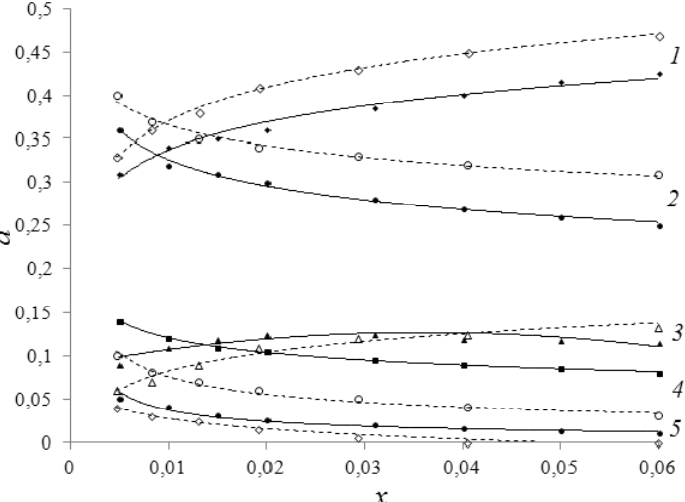
a dim( ) a dim( ) (1) and ferromagnetic f (2) Fe III ( ) Fe III ( ) a ( ) a ( ) (3) and ferromagnetic trim f (4) exchange Fe III ( ) Fe III ( ) a ( ) exchange type on the fraction of iron atoms in Fe III ( )